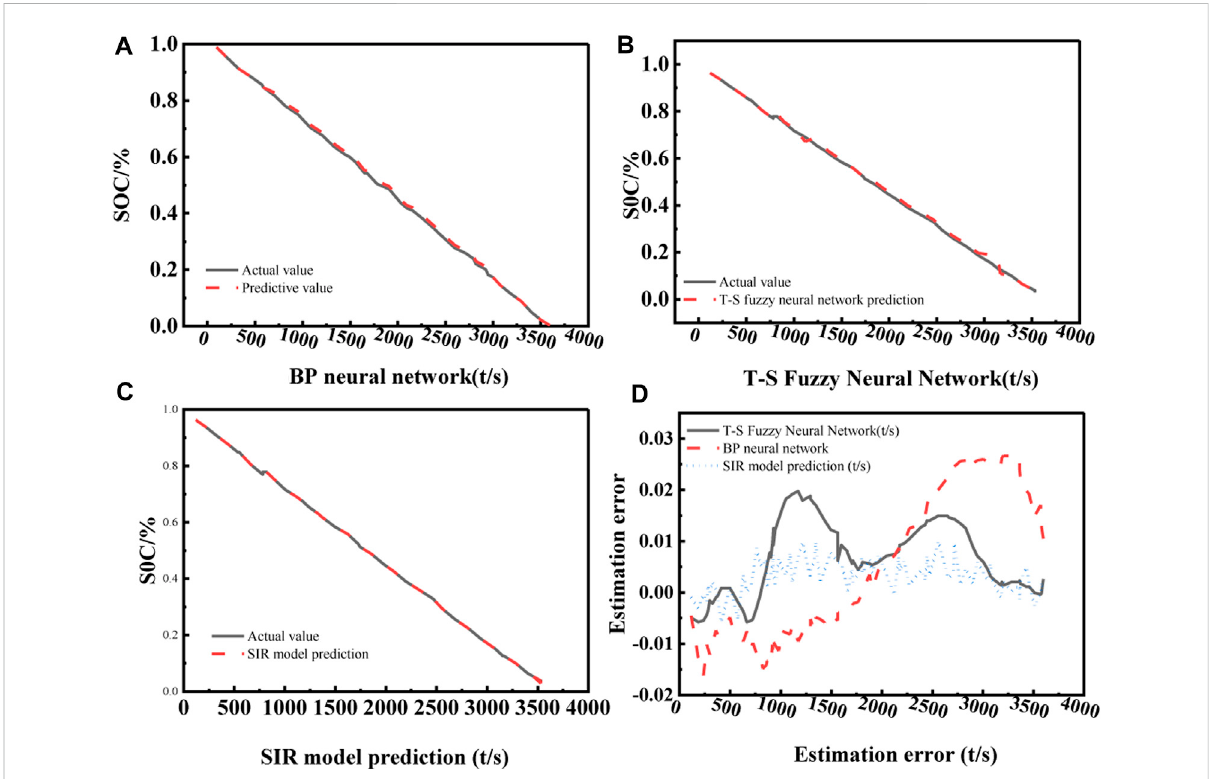
FIGURE 2 Prediction results of the sixth group of experiments. (A) the BP neural network has an error between the SOC prediction and the real value, but thevalueissmall. Observing (B) ,itcanbeseen thattheT-Sfuzzy neuralnetwork has obvious errorsat3000s,indicating that thereisasmallgap with therealvalue. (C) showstheSIRmodel.TheSOCpredictionoftheSIRmodelisalmostclosetotherealvalue,andisbasicallyinacoincidentstate.The SIR model can ensure that the error is within a certain range. It can be seen from (D) that the maximum estimation errors of the SIR model, BP neural network and T-S fuzzy neuralnetworkare 0.0189,0.021,and 0.026,respectively. Throughthesimulation results oftheMATLABplatform,itis concluded that the root mean square error (RMSE) of the SIR model, BP neural network and T-S fuzzy neural network are 0.003203, 0.044561, and 0.018213, respectively.